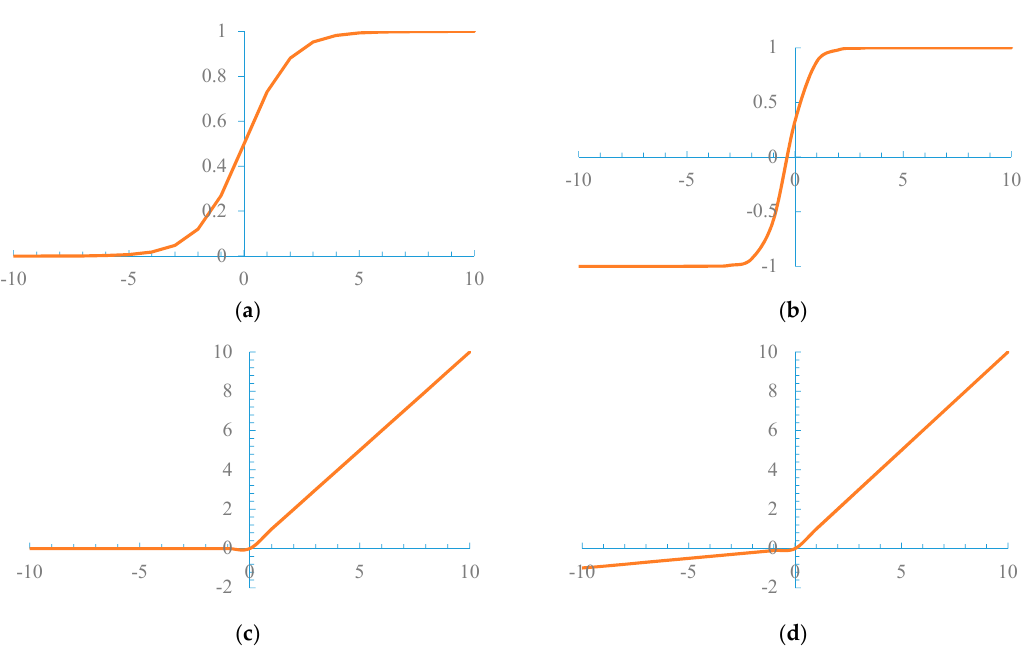
Figure 5. Nonlinear function. ( a ) Sigmoid function; ( b ) Tanh function; ( c ) ReLU function; ( d ) Leaky ReLU function.